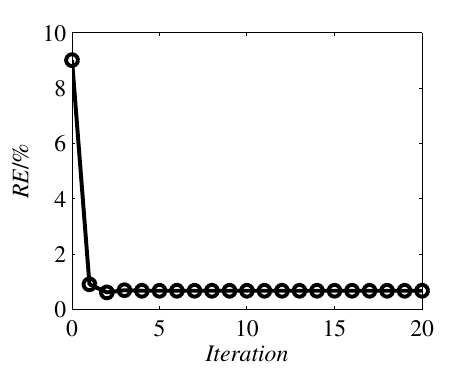
Figure 6. The RE due to iteration